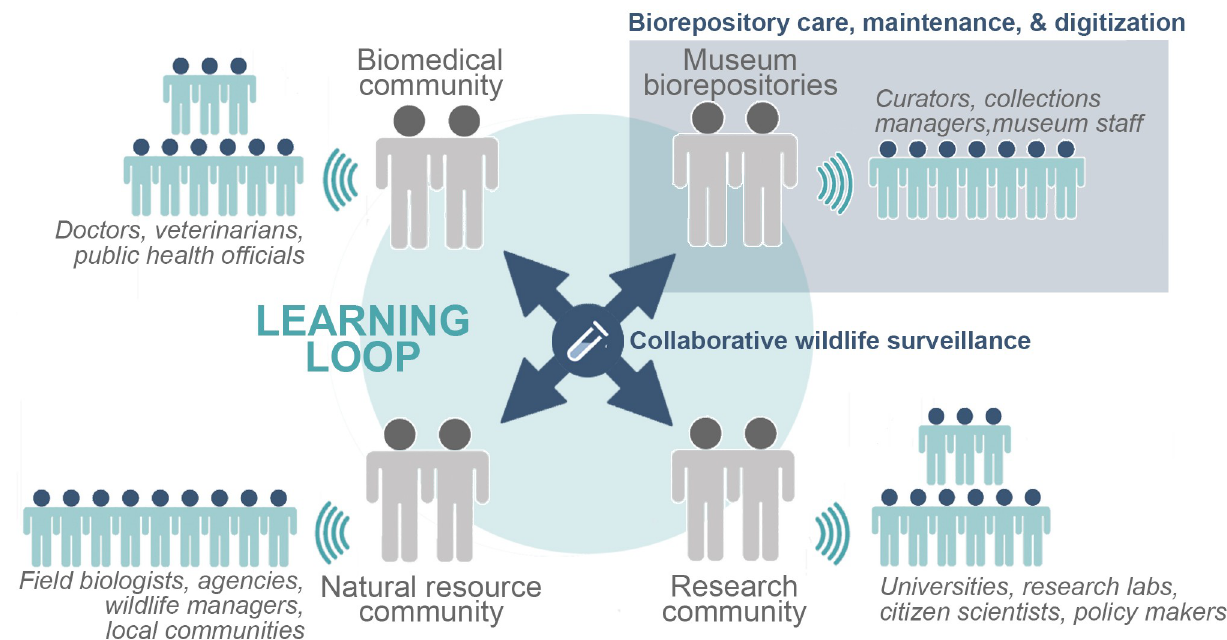
Fig 3. Multi-stakeholder Project ECHO learning loop or “hub” model that unites biorepository (e.g., museum), biomedical, natural resource, and research (e.g., EID, biodiversity, ecology, evolution, virology, pathobiology, etc.) communities, among others, to reciprocally share best practices and develop global wildlife sampling strategies for effective EID research and response, as well as studies of biodiversity. Under this model, geographically and taxonomically diverse specimens collected across disciplines and projects will be permanently archived in biorepositories for (a) long- term care, maintenance, and digitization, and (b) continued use and reuse by the global research community. EID, emerging infectious disease; ECHO, Extension for Community Healthcare Outcomes.